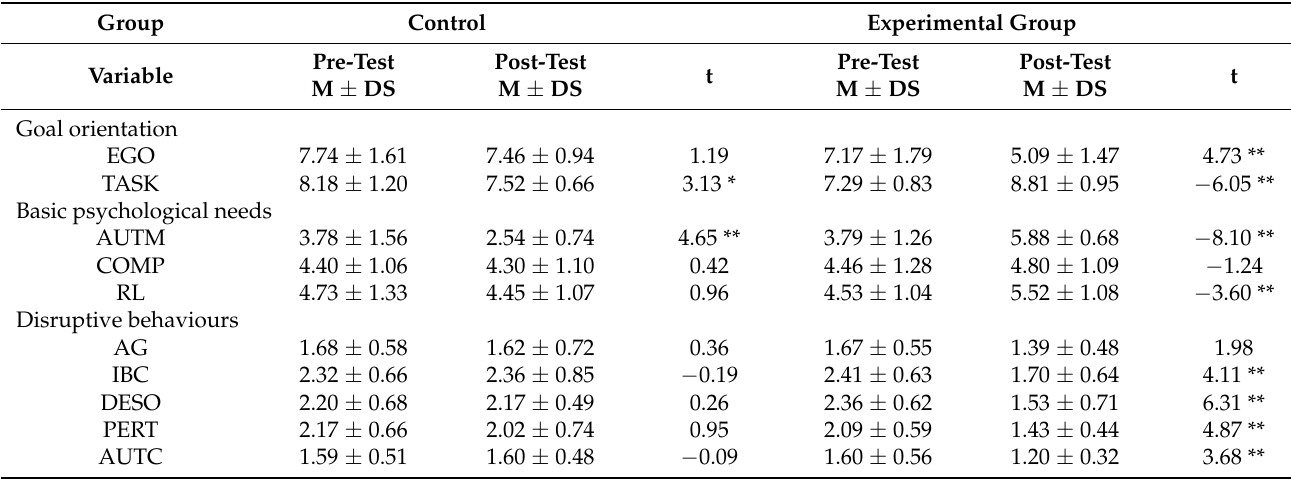
Table 4. Intra-group differences (pre-test vs. post-test) by intervention